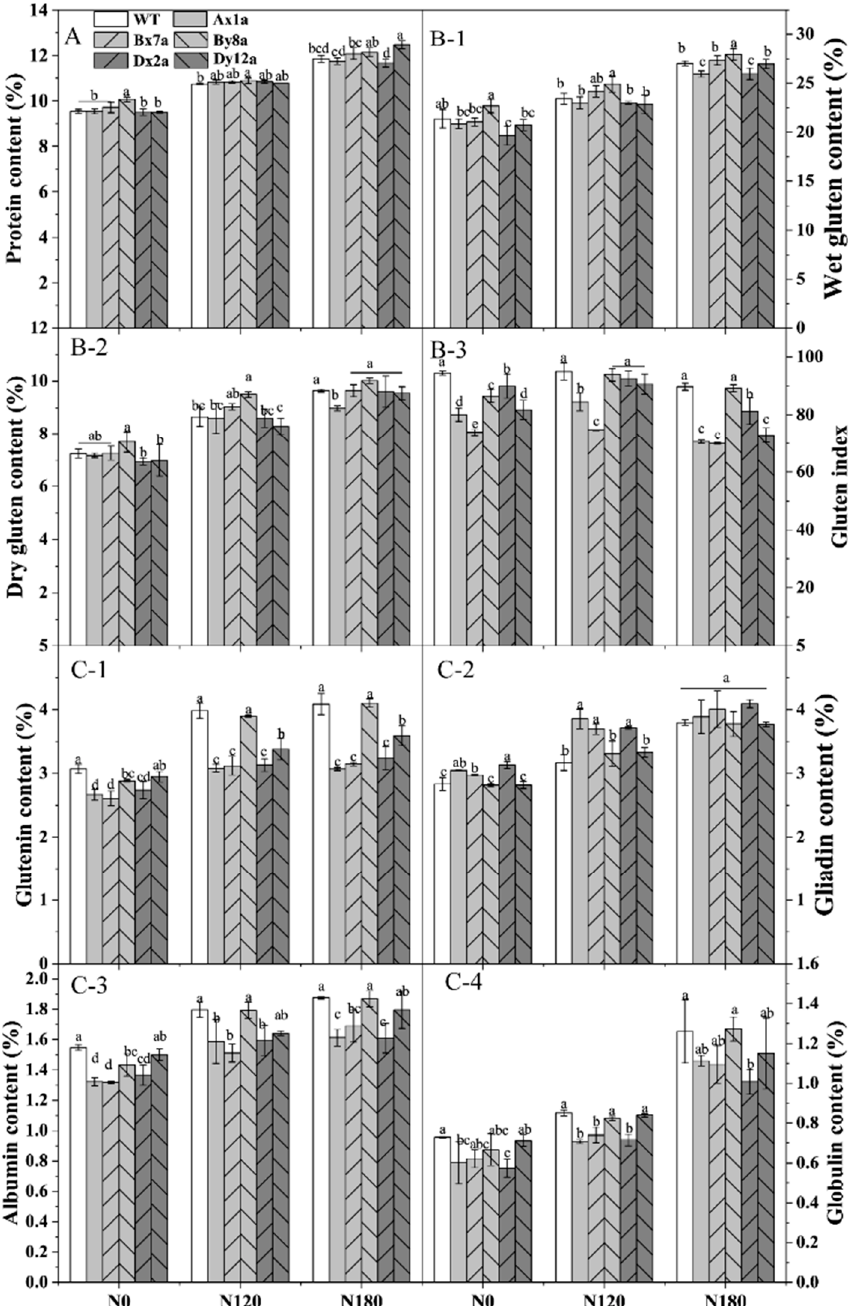
Figure 1. Content of protein ( A ), wet gluten ( B-1 ), dry gluten ( B-2 ), gluten index ( B-3 ) and protein components (glutenin, C-1 ; gliadin, C-2 ; albumin, C-3 ; globulin, C-4 ) in wheat lines with the absence of HMW-GS under different N treatments. The data of protein content represent the means based on two years. Different letters in the same N level for different wheat lines indicate a significant difference ( p < 0.05).